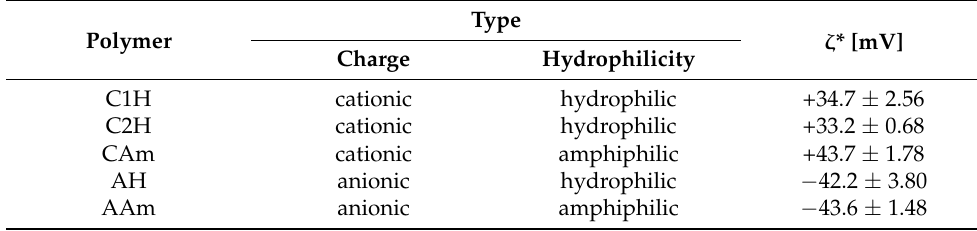
Table 1. Zeta potential of PAH derivatives in 0.015 M NaCl at 22 °C. Polymer